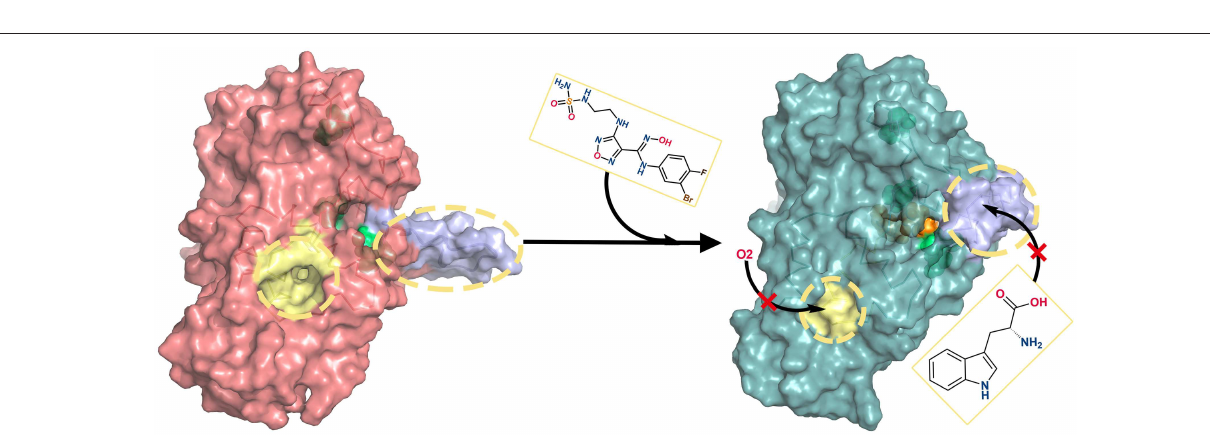
FIGURE 10 | Inhibition mechanisms of INCB024360. In the absence of INCB024360, the ligand delivery tunnel (colored in yellow) of IDO1 is spacious, and the substrate/product shuttle channel (colored in purple) is opened. After binding inhibitor, ligand delivery tunnel becomes so narrow that small molecules (such as O 2 ) cannot enter smoothly. Simultaneously, the substrate/product shuttle channel turns off and prevents substrate Trp from arriving in the IDO1 catalysis